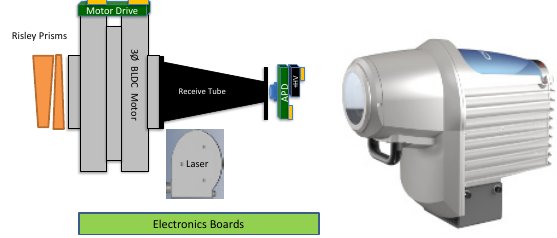
Figure 1: OPAL-120 Hardware Architecture